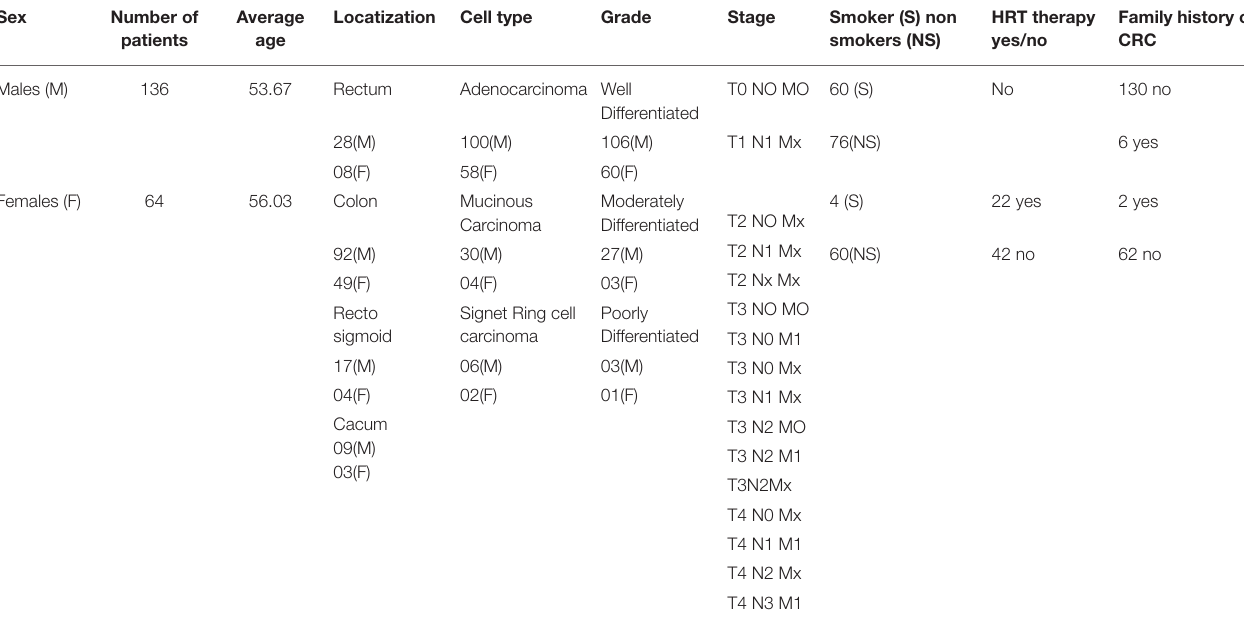
TABLE 1 | Baseline characteristics of CRC patients ( n = 200).